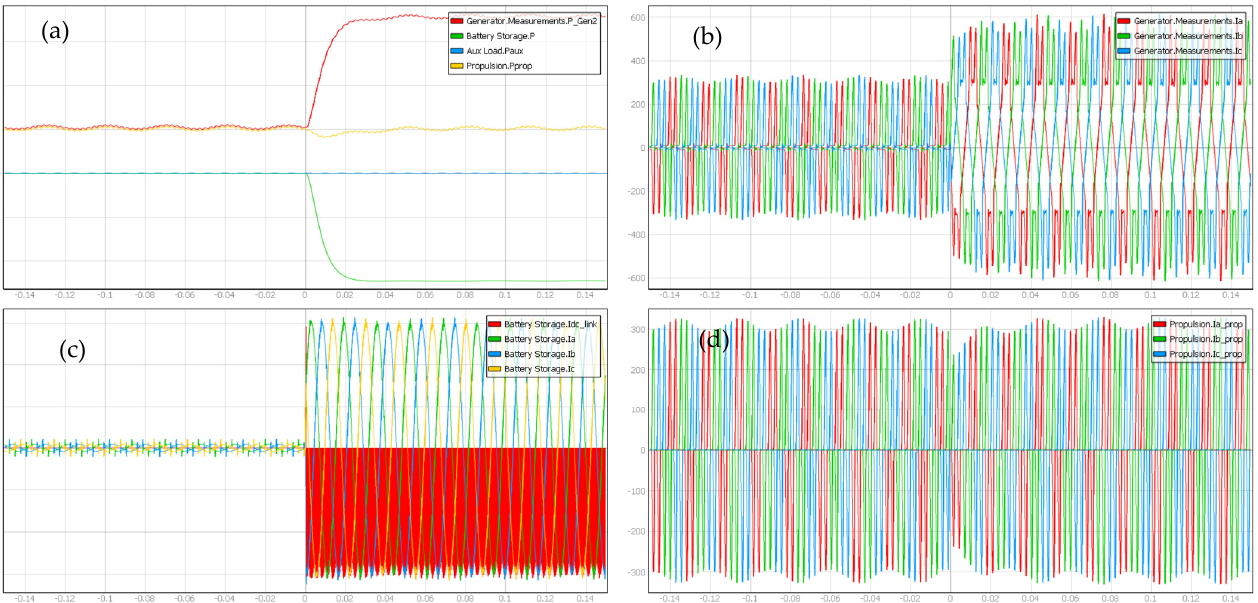
Figure 11. Results of case study 2/Scenario B. From left to right, top to bottom: ( a ) power associated with diesel generator, battery, auxiliary load and propulsion system; ( b ) diesel generator currents; ( c ) battery currents (at the battery itself and at the output of the filter); ( d ) input currents to the propulsion system.